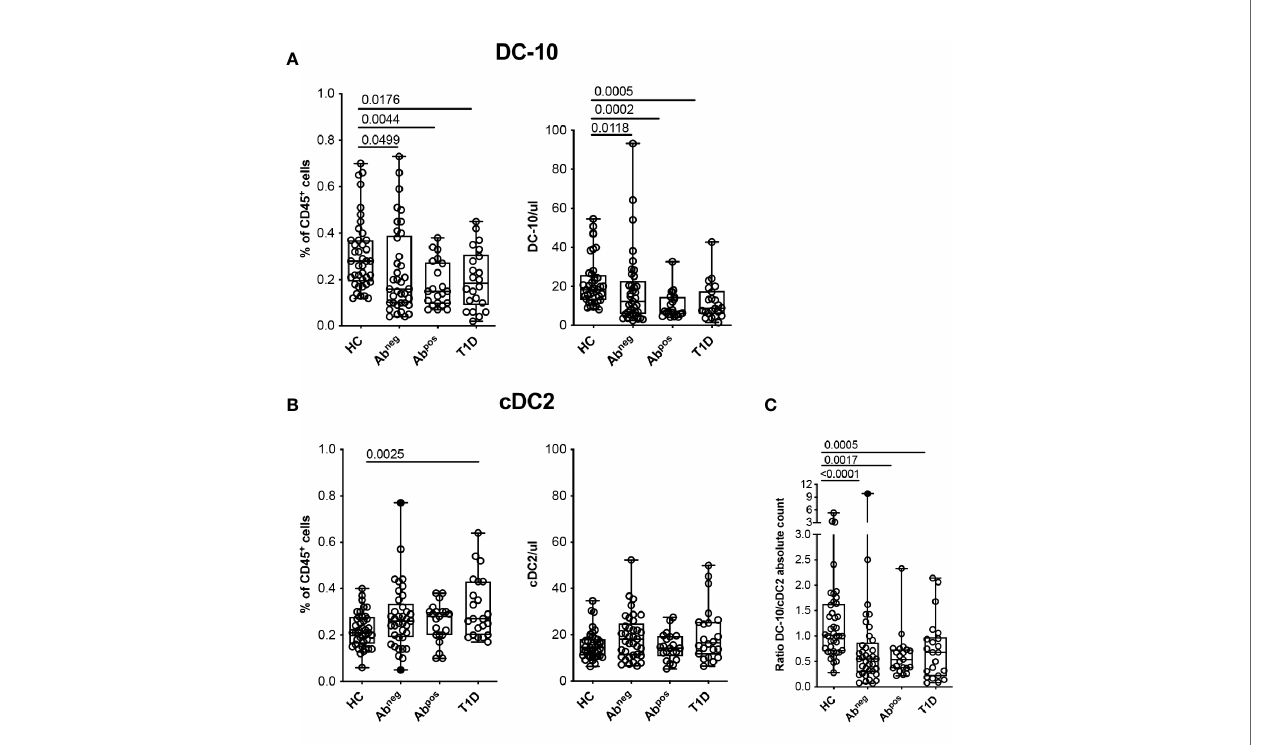
FIGURE 3 | Tolerogenic DC-10 are reduced in type 1 diabetes (T1D) patients and in both Ab neg and Ab pos fi rst-degree relative (FDR) subjects. DC-10 (CD11c + CD14 + CD16 + CD141 + CD163 + ) and cDC2 (CD11c + CD1c + ) were identi fi ed by multiparametric fl ow cytometry in the peripheral blood of pediatric healthy donors (HCs; n = 40), of age-matched fi rst-degree relatives of T1D patients without (Ab neg , n = 37) or with (Ab pos , n = 21) autoantibodies, and pediatric T1D patients at onset (T1D, n = 22). The frequency and absolute cell count of (A) DC-10 and of (B) cDC2 in the indicated cohort of donors are shown. (C) Ratio between DC-10 and cDC2 as absolute cell count was calculated for each donor. The absolute cell counts of DC-10 and cDC2 were obtained by normalization of the CD45 + cells based on the full blood count laboratory test. Each dot represents a single donor, and black dots in the Ab neg group indicate donors identi fi ed as outliers by the corresponding linear mixed-effects (LME) model used for the comparing groups; lines indicate medians, and whiskers are minimum and maximum levels. For each set of data, post-hoc analysis of the LME model with the R package phia was performed for testing the difference between all groups. Numbers indicate statistically signi fi cant Bonferroni ’ s adjusted p-values. The p-values of all comparisons are reported in Supplementary Tables S2, S4 . In the LME analysis, data on the percentage of DC-10 and cDC2 cells were used in square root scale, while data on absolute cell counts (even the ratio DC-10/cDC2) were used in natural logarithmic scale in order to meet the assumptions of the